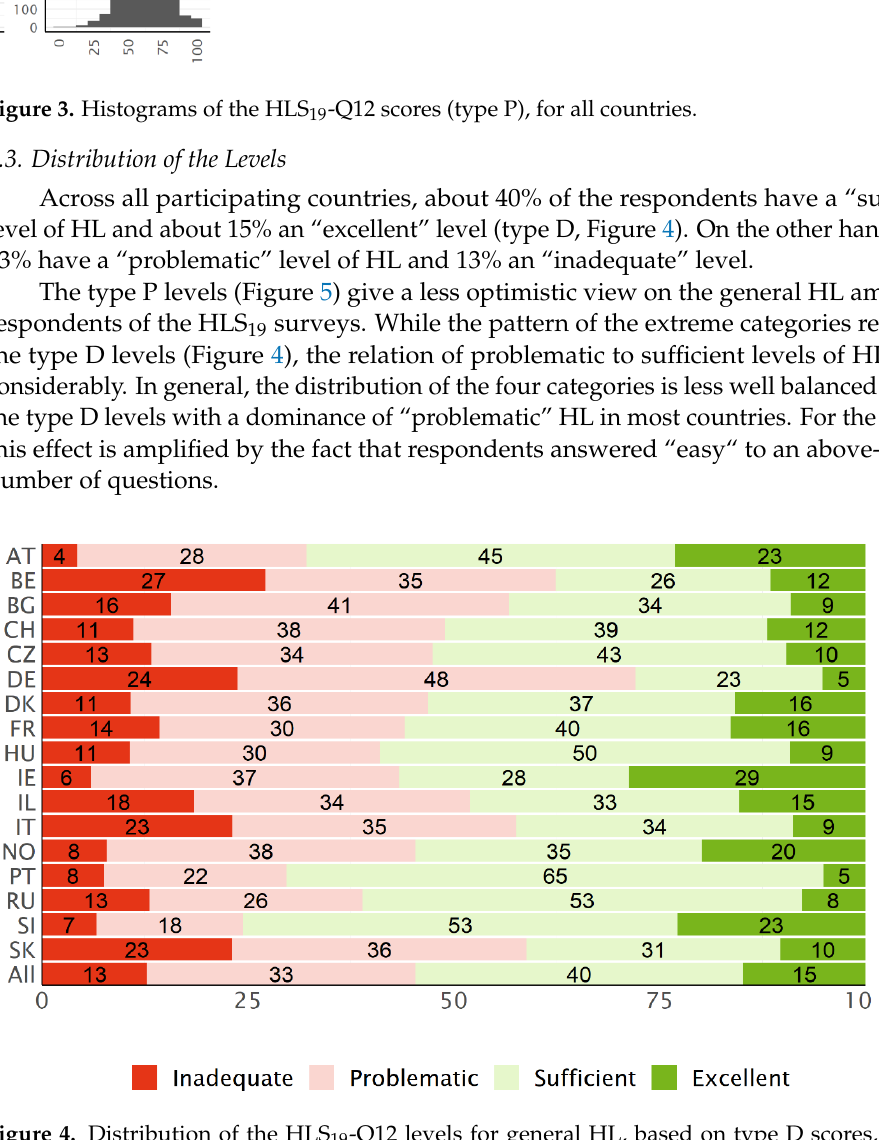
Figure 3. Histograms of the HLS 19 -Q12 scores (type P), for all countries.